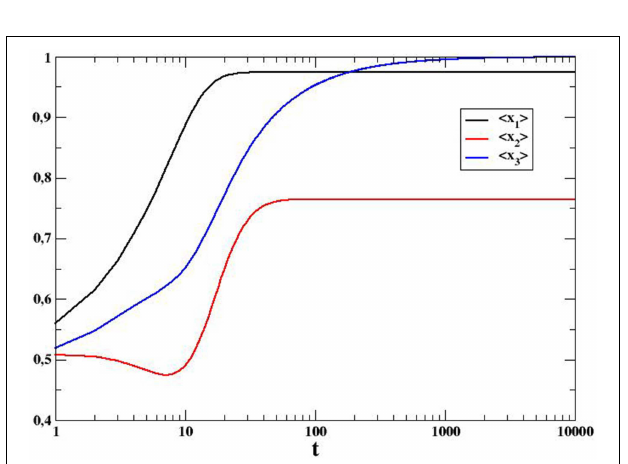
FIGURE 4 | Behavior over time of average internal variables for a system of N = 100 on a one-dimensional ring and initial average opinion h O 0 i = 0 . 5 . Averages over 2000 independent